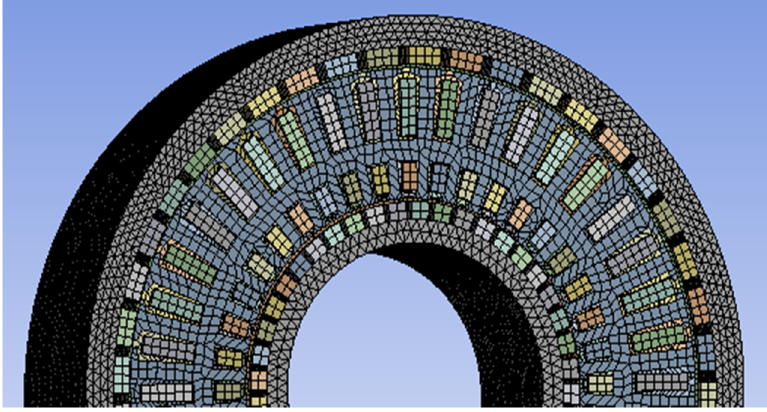
Figure 11. The three-dimension (3-D) graph of the mesh division of 1 kW DRPMSM.